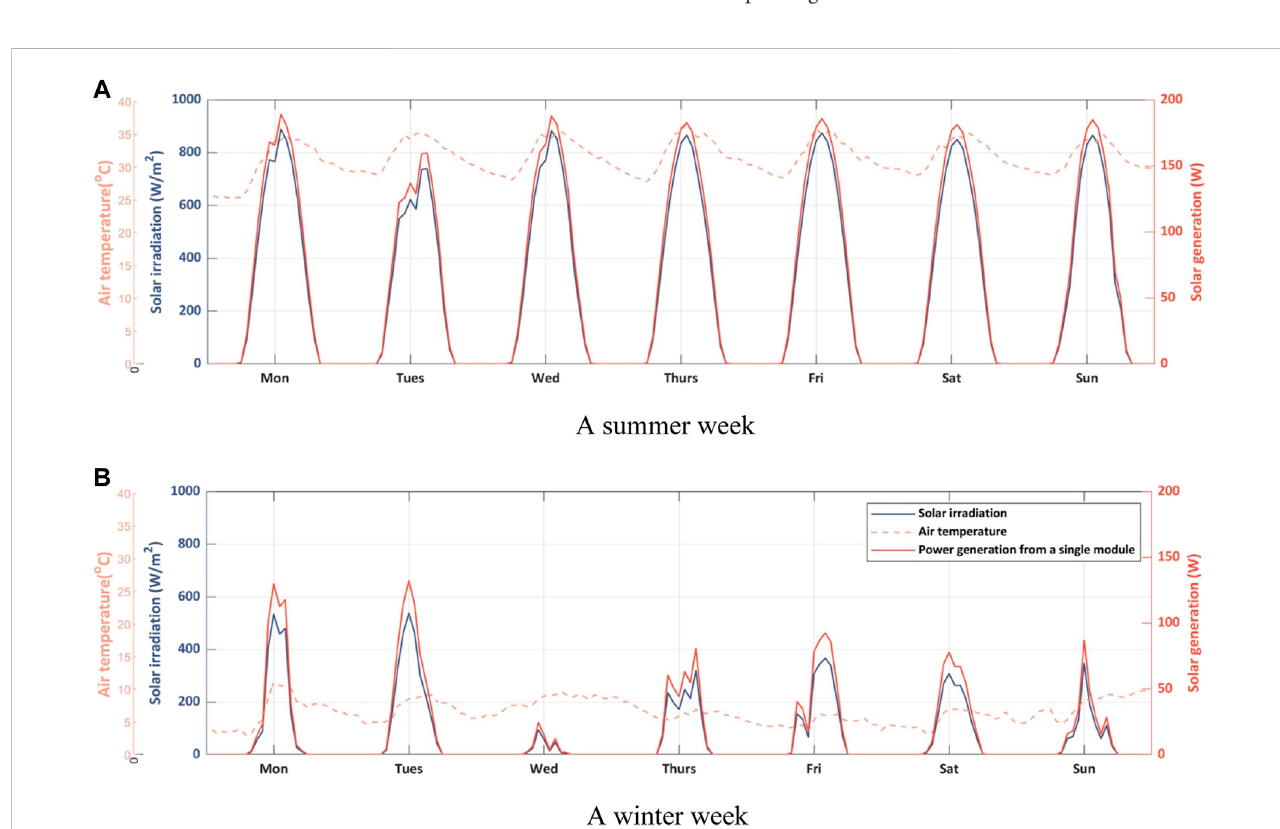
FIGURE 2 Weather factors and PV generation of typical weeks: (A) a summer week, (B) a winter week.